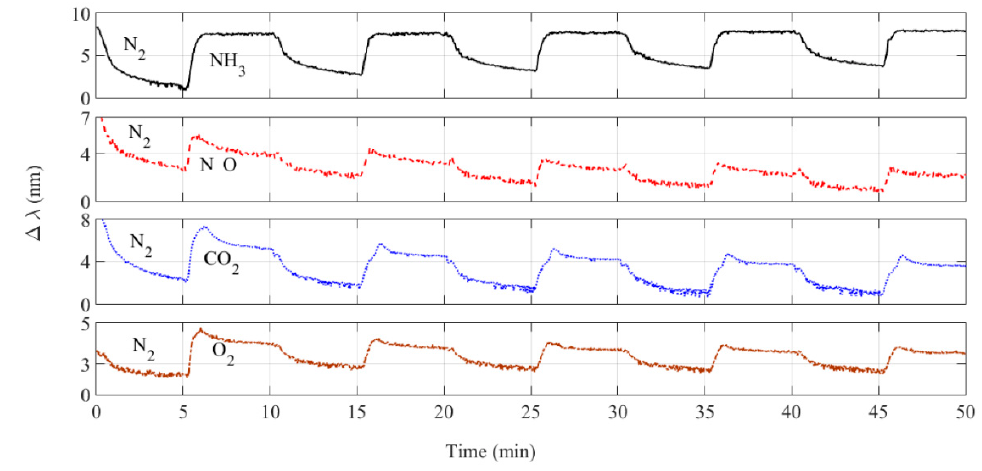
Figure 2. LMR wavelength shift when the sensitive region of the device is exposed to different concentrations of NH 3 (1890 ppm), NO (301 ppb), CO 2 (pure) and O 2 (pure) for cycles of 5 min followed by 5 min of recovery time in N 2 .